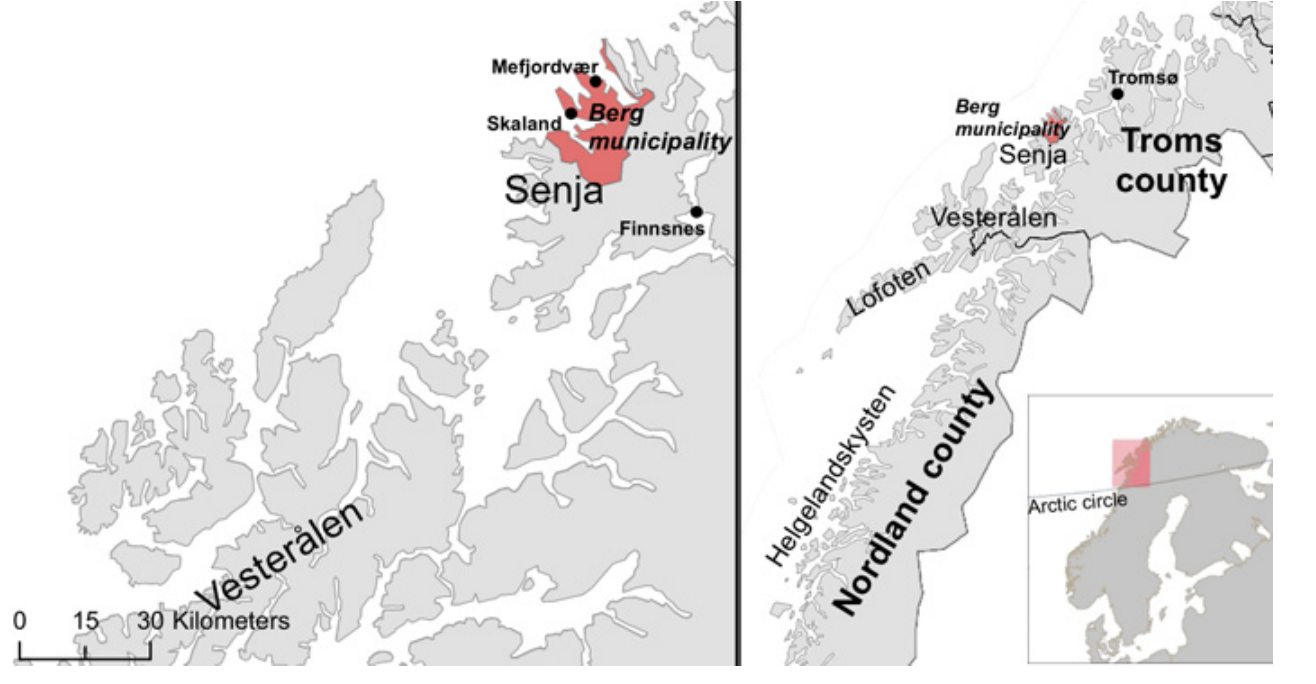
Map source: Statens kartverk (Norwegian Mapping Authority); adapted by